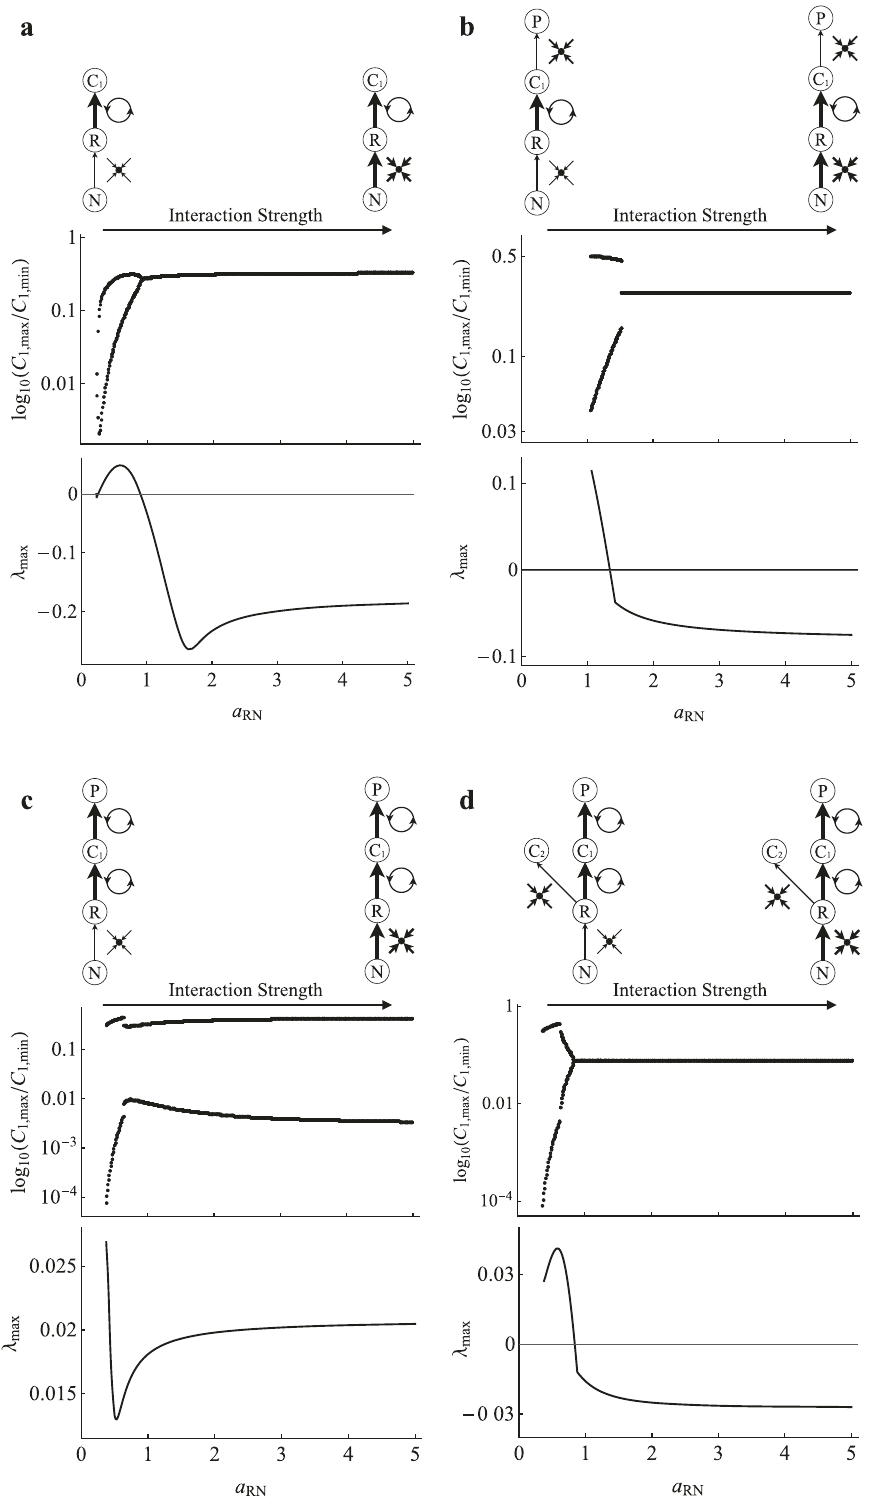
Fig. 5 Nutrient-limited food chain stability. a – d Non-equilibrium dynamics (log 10 ( C 1,max / C 1,min )) and equilibrium stability (real part of the dominant eigenvalue; λ max ) of the C – R – N, P – C – R – N with a single oscillator, P – C – R – N with coupled oscillators, and P – C 1 – C 2 – R – N modules, respectively, as a RN is